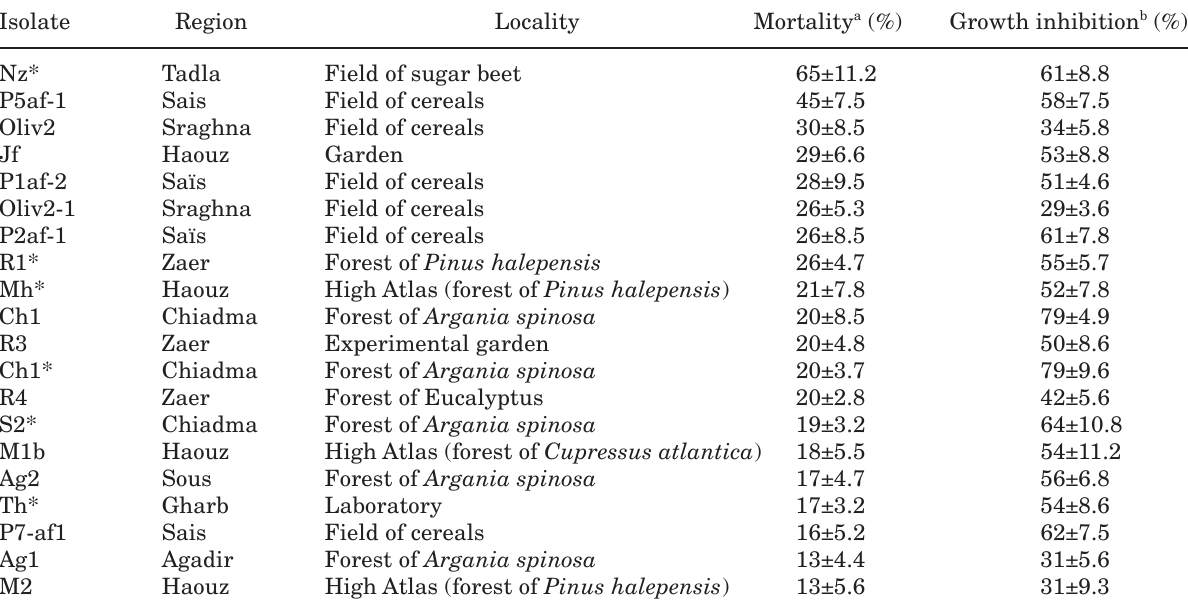
Table 2. Antagonistic action of Trichoderma isolates originating from other region of Morocco on S. rolfsii .